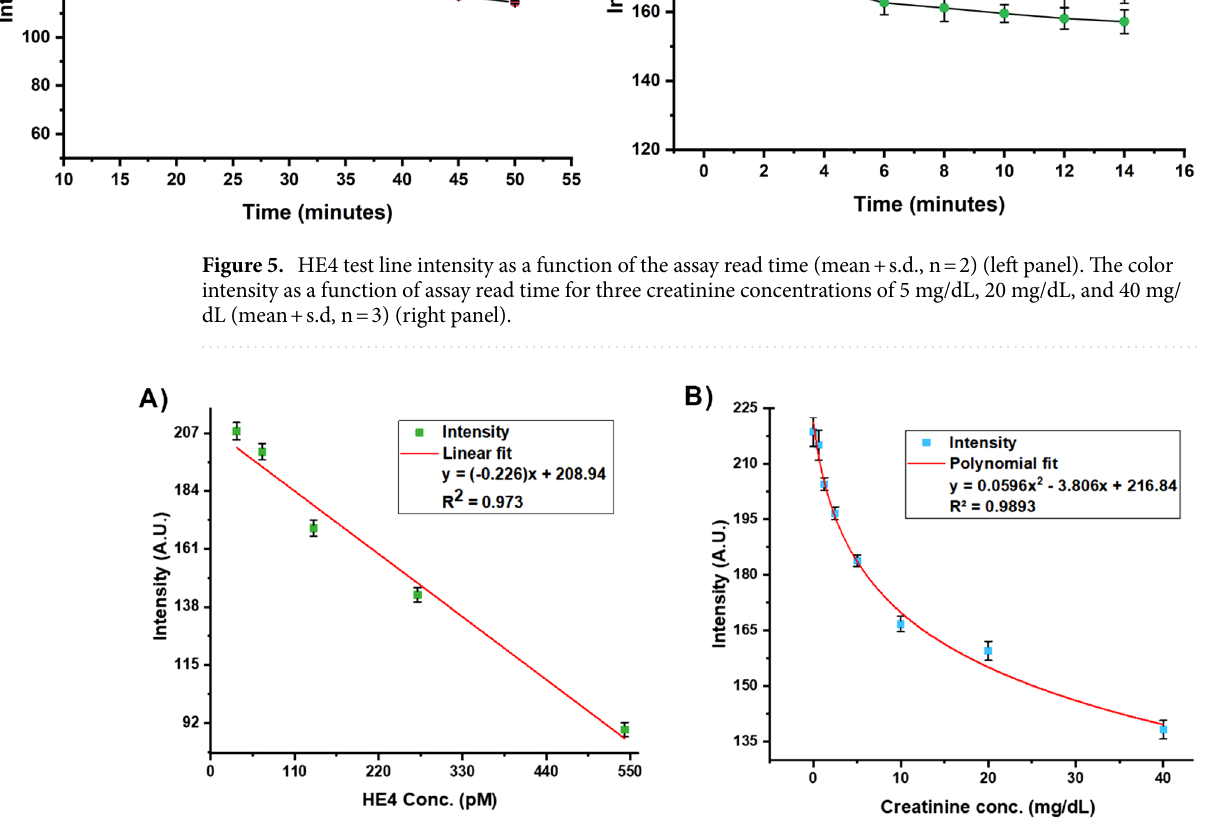
Figure 6. Calibration plots generated from the scanner. ( A ) Standard curve for concentrations of HE4 (pM) (mean + s.d, n = 2). ( B ) Standard curve for concentrations of creatinine (mg/dL) (mean + s.d, n =